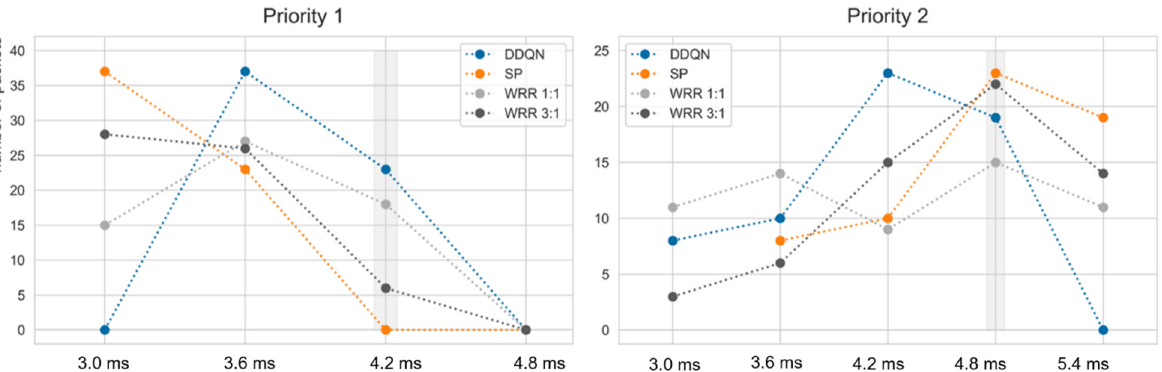
Figure 11. E2E of the DDQN, SP, and WRR scheduler in the mesh topology. The gray area denotes the deadline of priority 1 and priority 2 packets. The total packet number of each priority is 60.